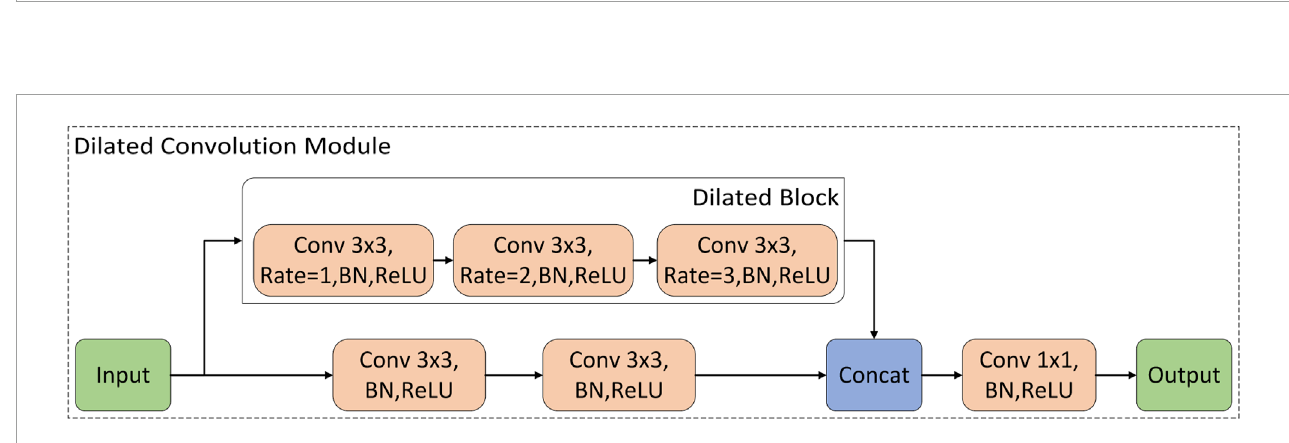
FIGURE 3 The structure of the dilated convolution